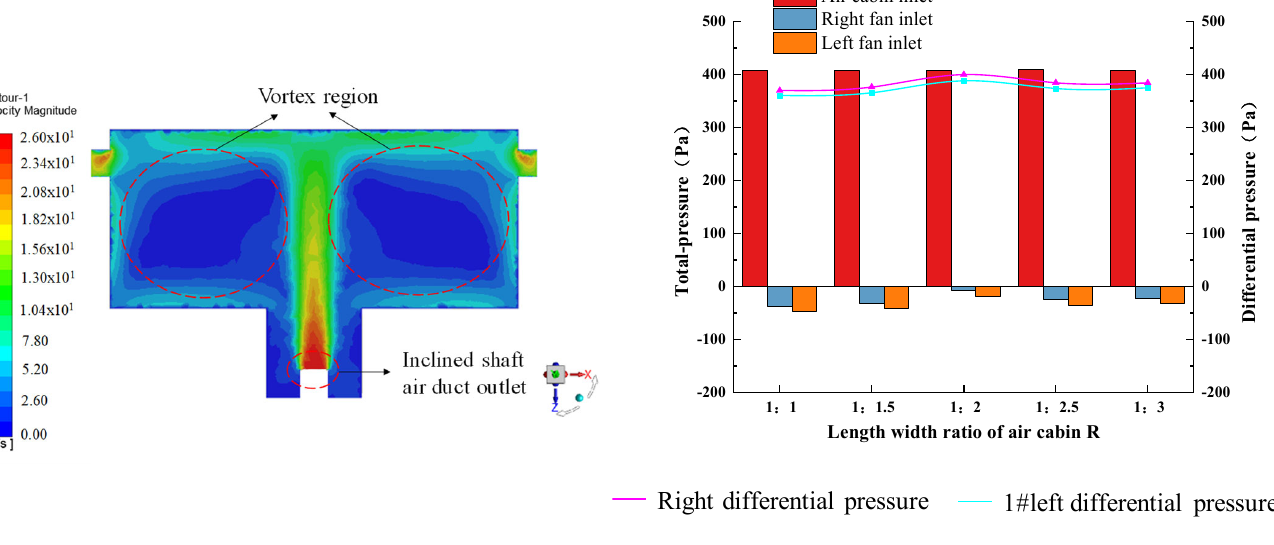
Figure 10. Airflow field distribution and differential pressure in different R .